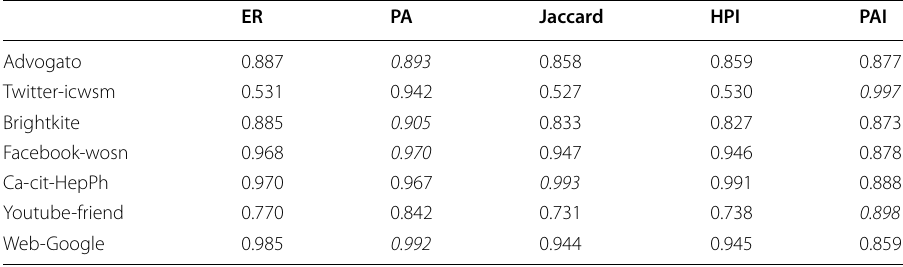
Italic indicates the best score of each experiment